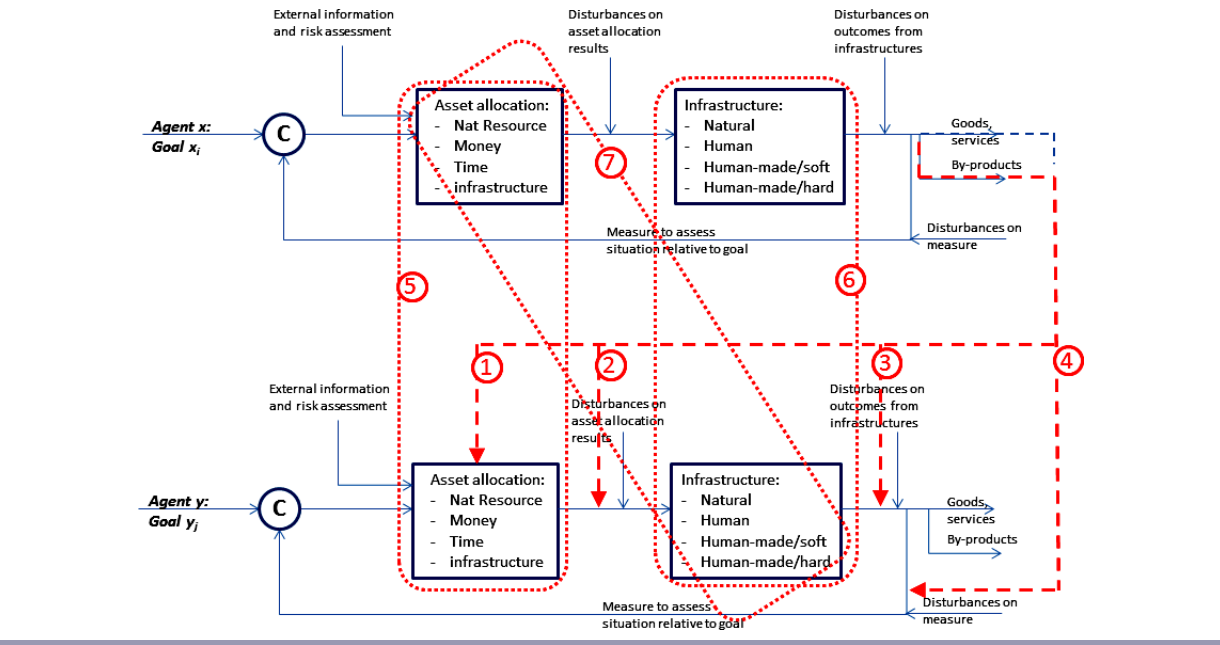
Fig. 2 . Possible interactions between one feedback control loop (FBCL) of an agent x and another FBCL of an agent y. x=y is allowed but